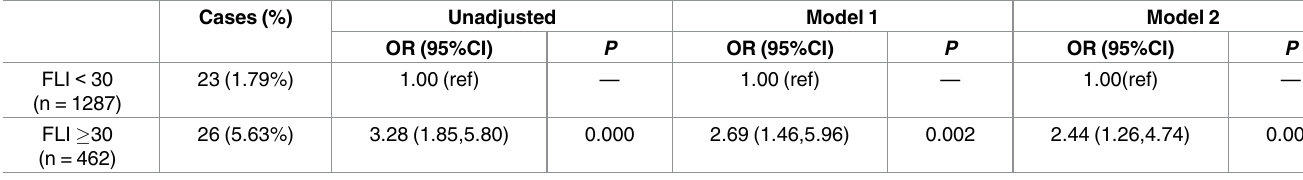
Table 3. Sensitivity analysis on the association between FLI with IVBS in cross-sectional